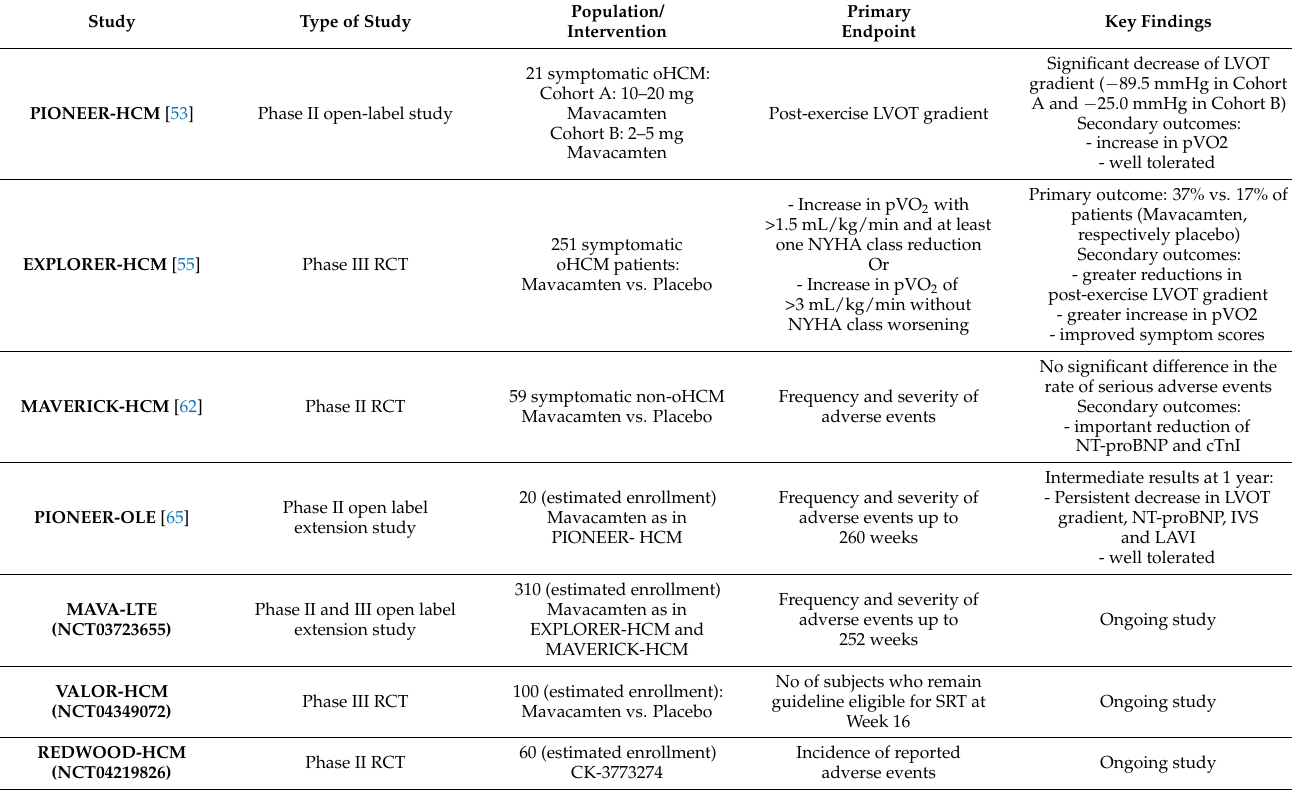
Table 1. Summary of clinical trials involving myosin